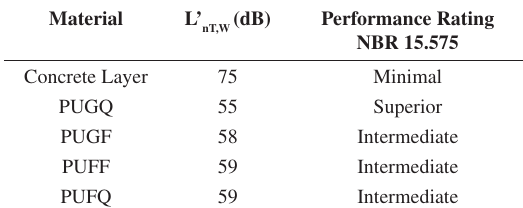
Table 2. Classification of acoustic performance.